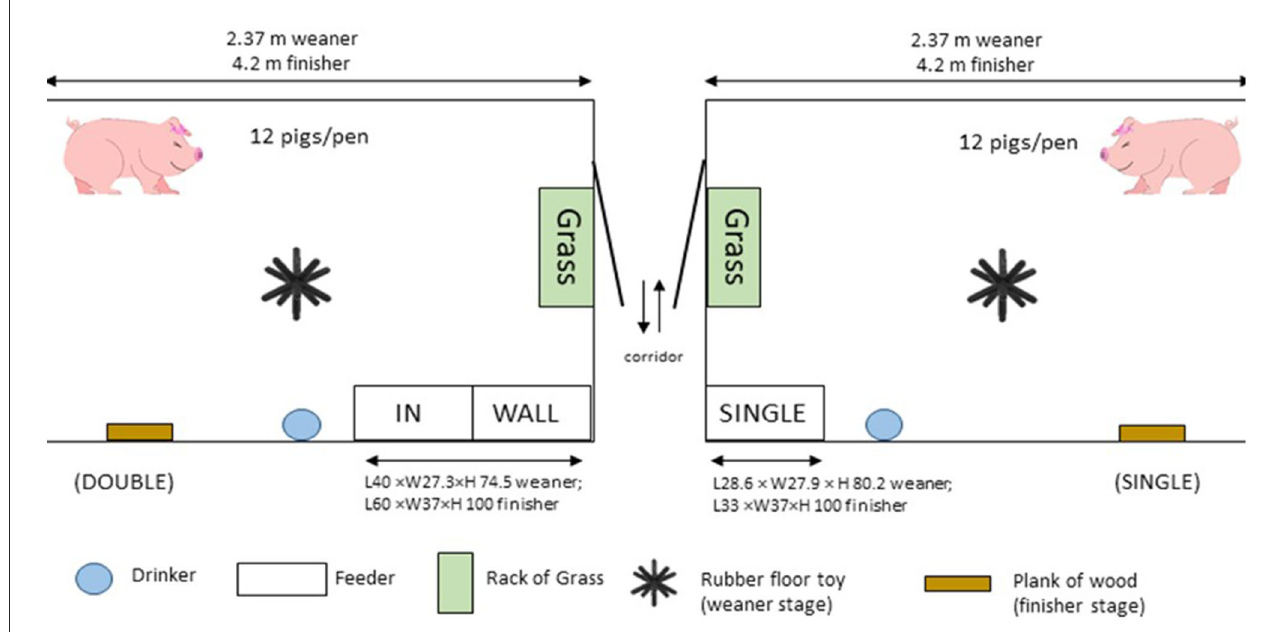
FIGURE1 Plan view of pen and feeder layouts for both DOUBLE and SINGLE treatments. DOUBLE pens had double-spaced feeders, one called WALL, which was aligned with the front wall of the pen, and IN, which was adjacent to WALL inside the pen. SINGLE had a single-spaced feeder aligned to the front wall of the pen.